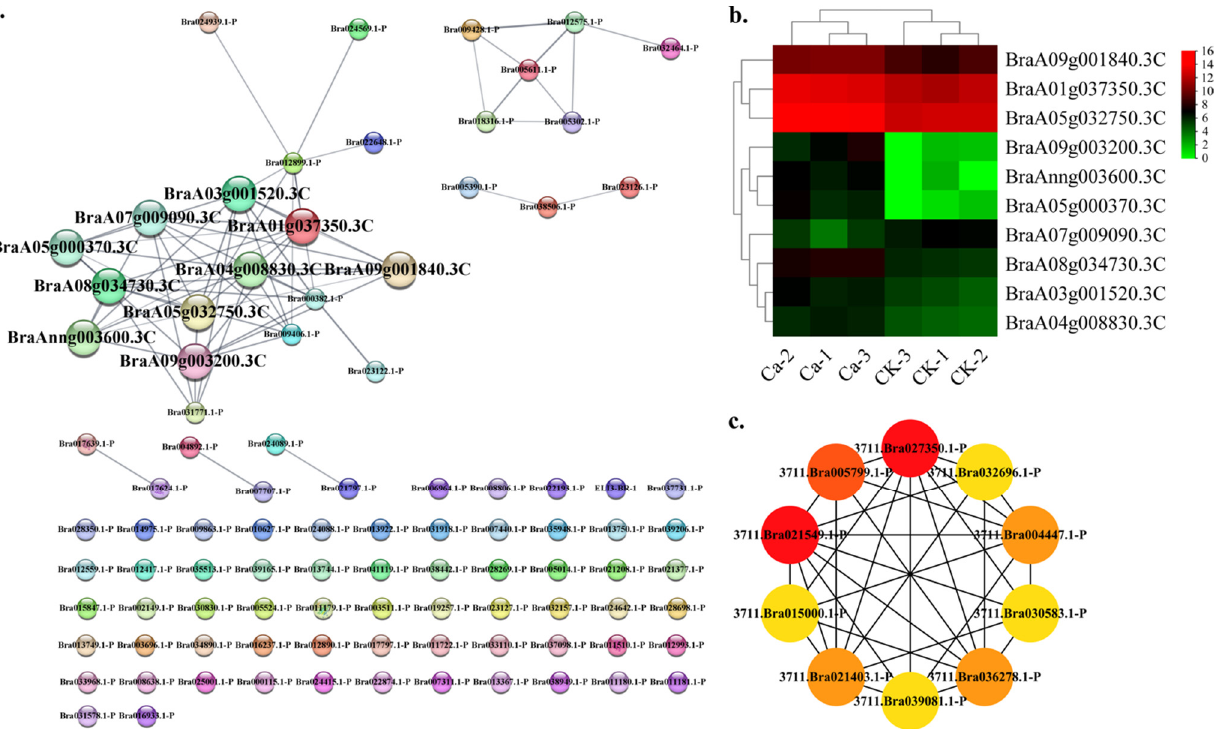
Figure 9. Protein–protein interaction (PPI) analysis in cell wall-related DEGs category. ( a ) PPI network in cell wall category. ( b ) Heatmap of the hub gene expression pattern. ( c ) Hub genes’ interactive relationship of the gene regulatory network.